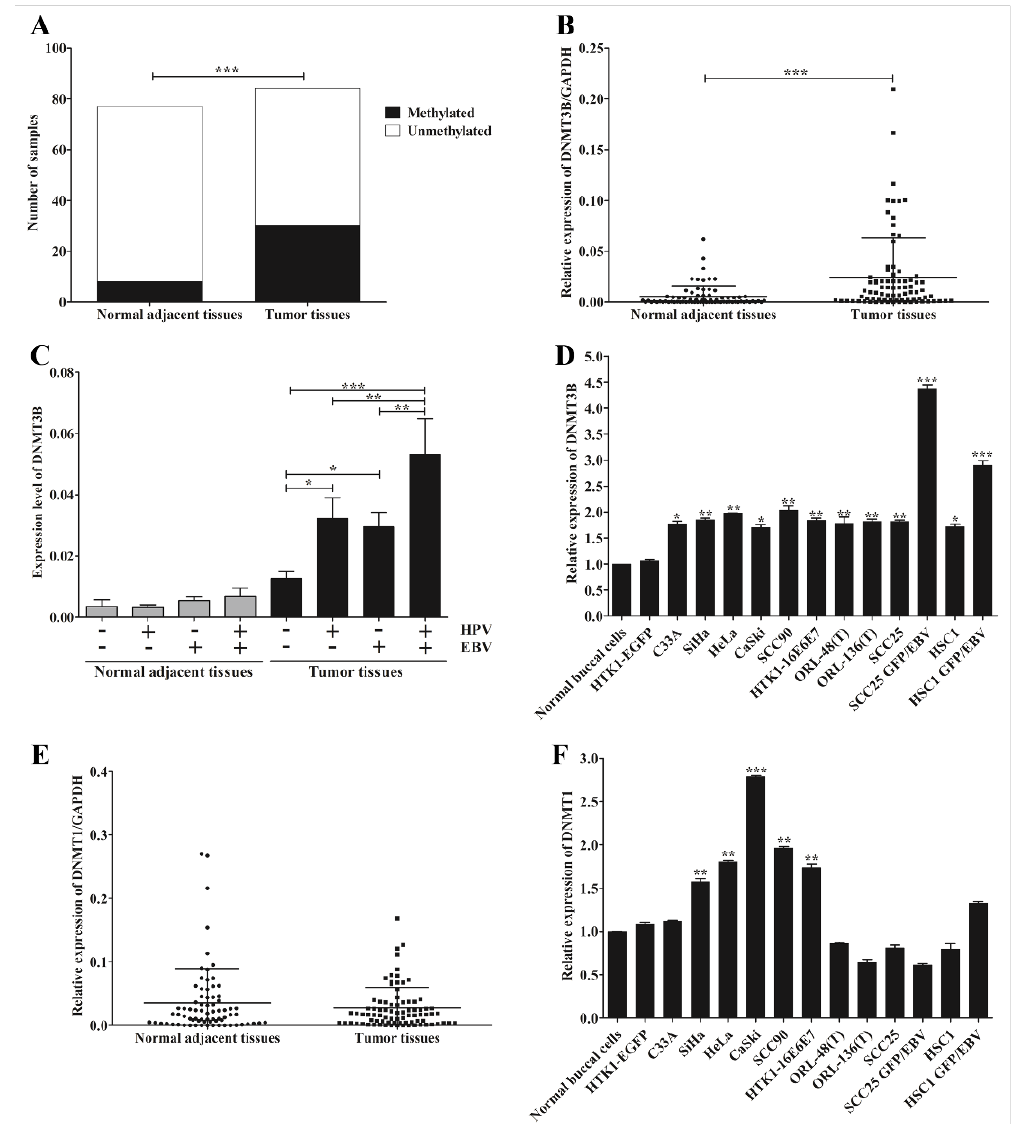
Figure 4. EBV silences miR-145 by DNA methylation via DNMT3B. The methylation status of miR-145 was determined by MSP using specific primers. The number of samples in which hypermethylation occurred in tumor and normal adjacent tissues ( A ). The expression of DNMT3B in OSCC tissues ( B ), OSCC tissues with or without the infection of EBV and/or HPV ( C ) and cancer cell lines ( D ) were examined by qRT-PCR. The expression levels of DNMT1 in OSCC tissues ( E ) and cell lines ( F ) were examined by qRT-PCR. *: p < 0.05; **: p < 0.01; ***: p < 0.001.